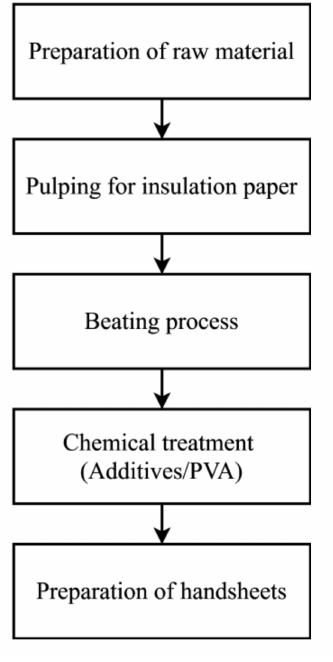
Figure 1. The process to produce Kenaf insulation